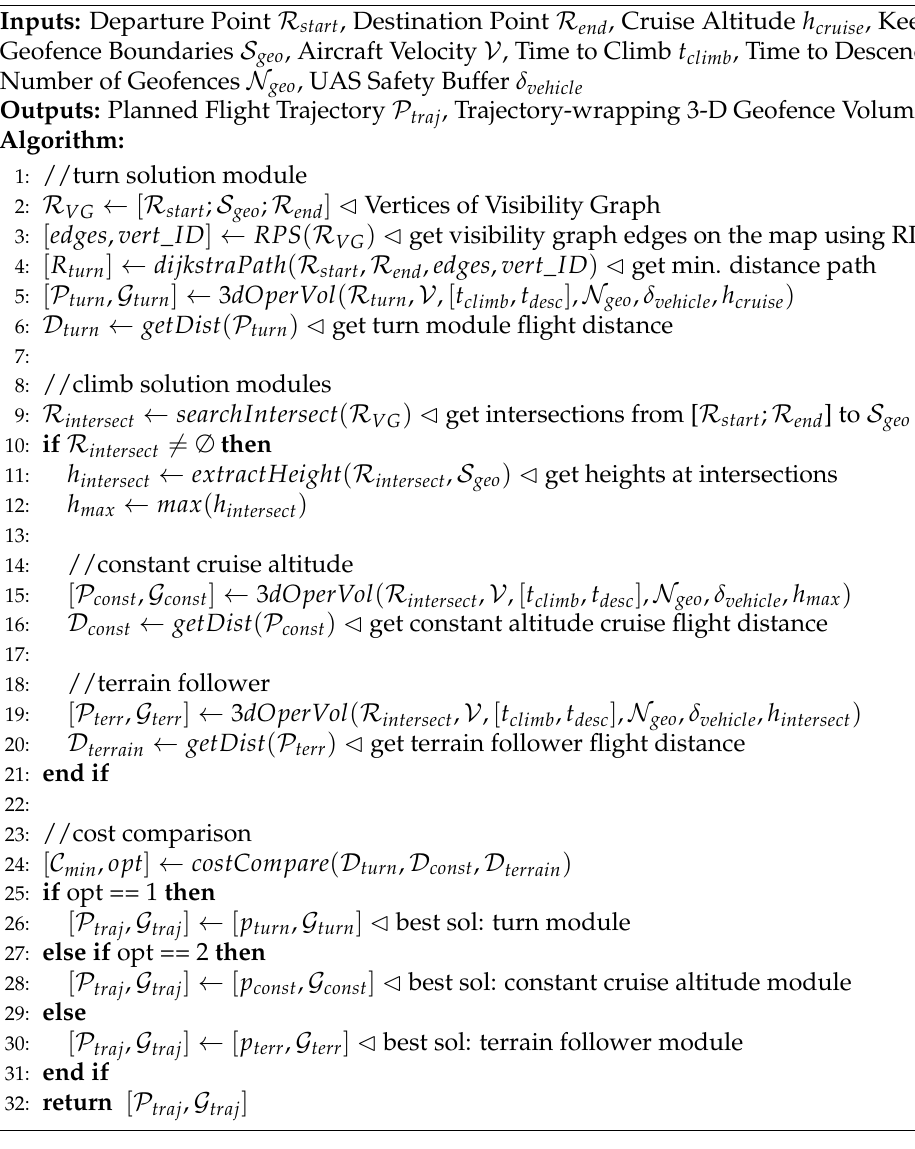
Algorithm 4 Flight Planning With